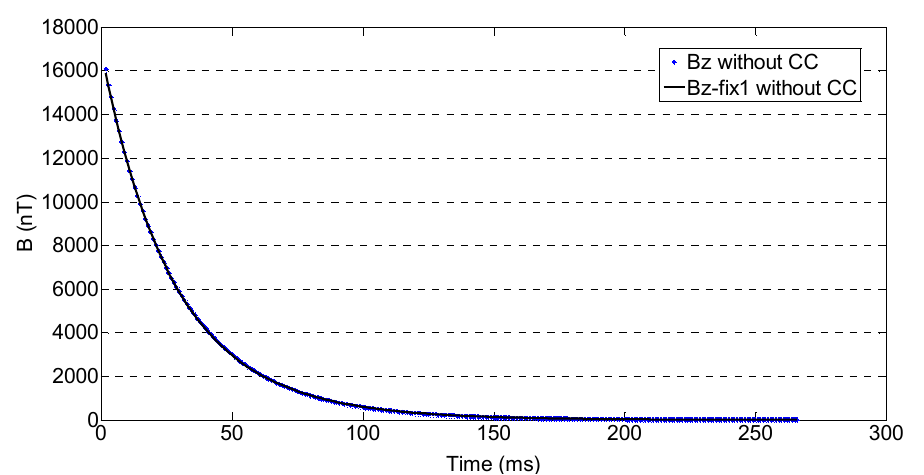
Figure 4. Curve fittings of the residual magnetic field in z direction without CC. ’+’ type of the blue curve is simulation data after t s = 2 ms; The black curve B z-fix 1 is the fitting curve.